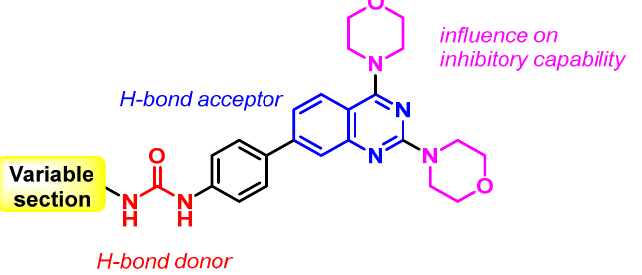
Figure 2. General structure of the target compounds.